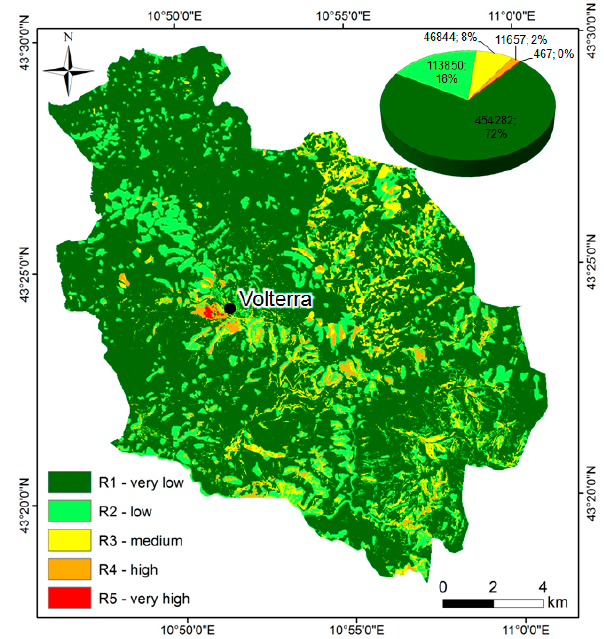
Figure 9. The pie chart shows the number of pixels and related percentage for each R s class. The 0% percentage of Specific Risk class R4 actually corresponds to a decimal value of 0.001.